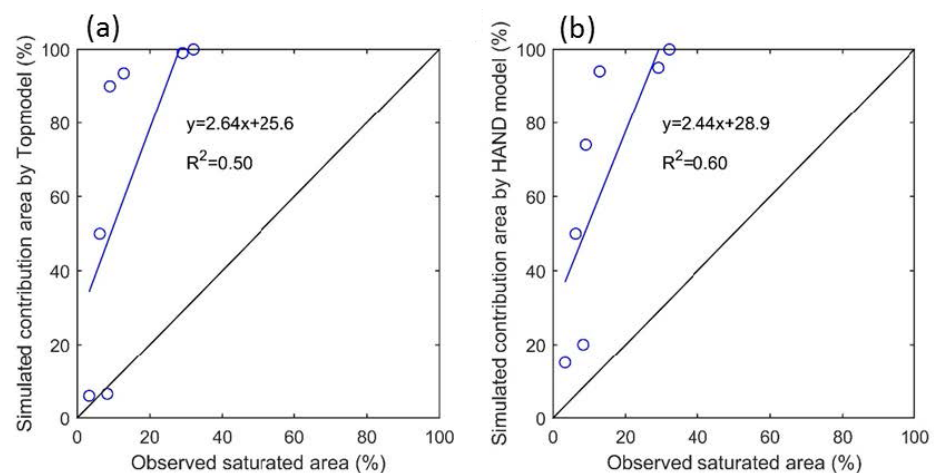
Figure 10. The comparison of the observed saturated area and simulated contributing areas by the TOPMODEL and HSC models.